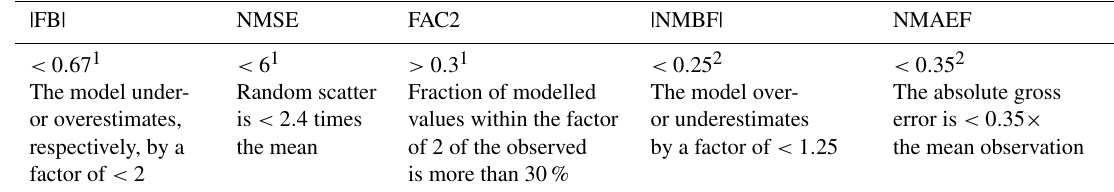
Table 5. The performance measures and acceptance criteria applied in the evaluation: fractional bias (FB), normalised mean squared error (NMSE), factor of 2 (FAC2), normalised mean bias factor (NMBF) and normalised mean absolute error factor (NMAEF). For more details on the acceptance criteria, see Hanna and Chang (2012) and Yu et al. (2006).